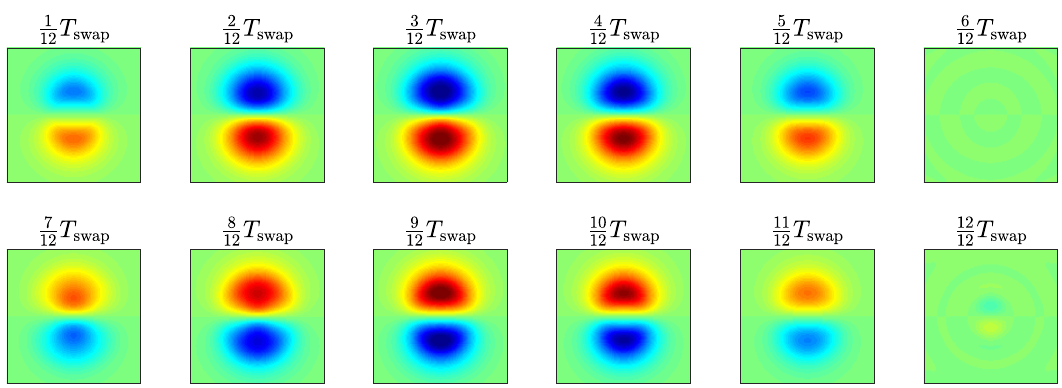
Figure 2. Evolution sequence of the charge density of the dipole CSQ in one charge-swapping period T . The red color depicts positive charge density and the blue color depicts negative swap charge density. T is usually a few times the oscillation period of the field, which is roughly swap T 0 ≡ 2 π/m = 2 π .